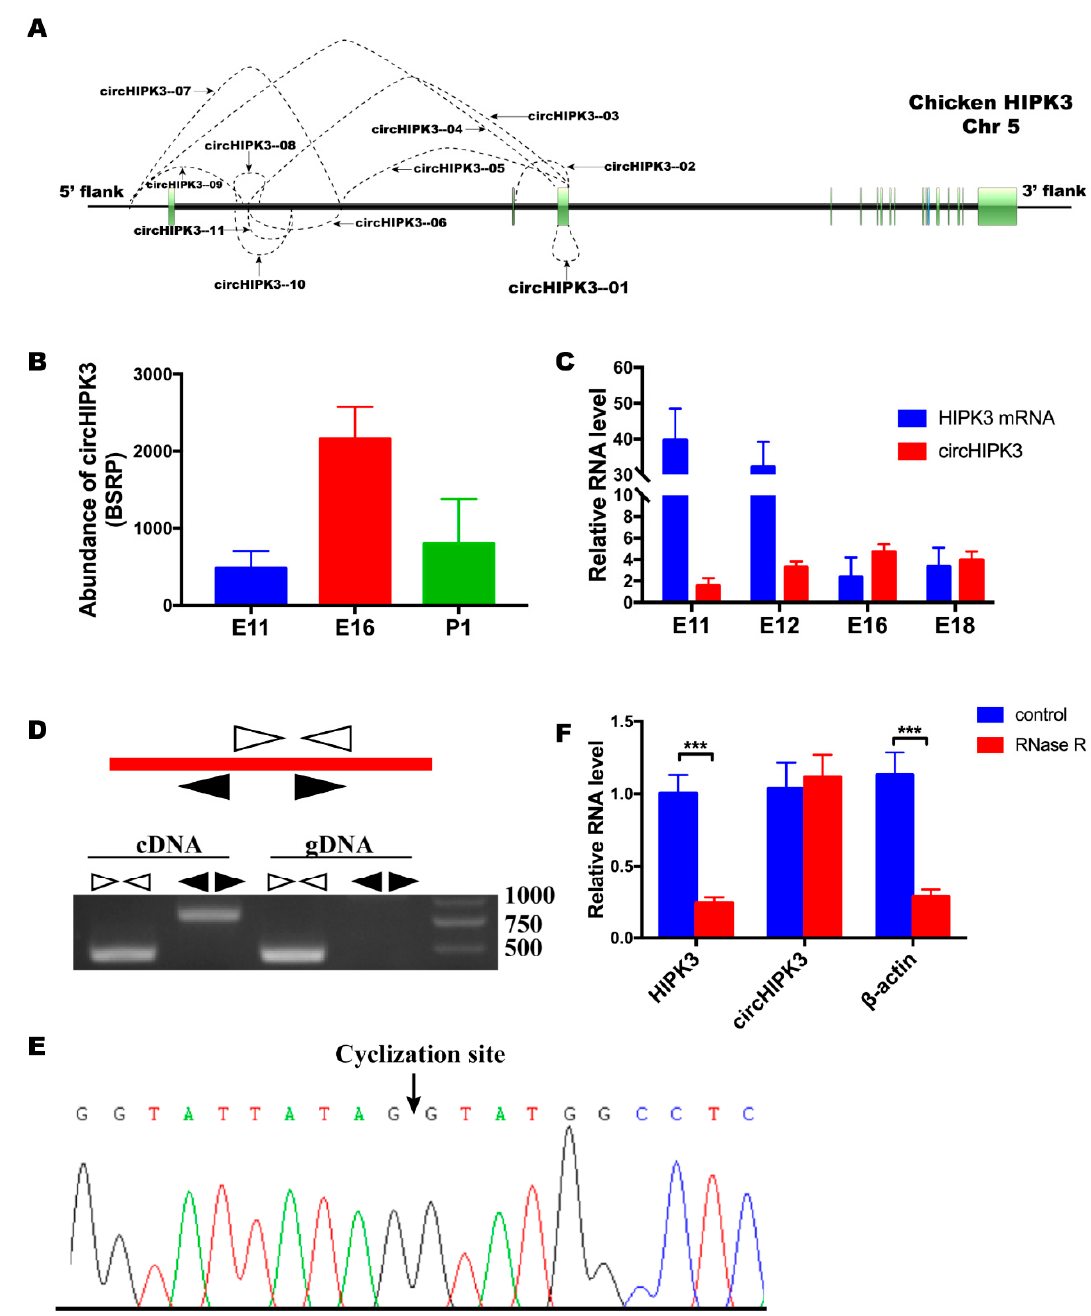
Figure 1. The differential expression and validation of circular HIPK3 (circHIPK3). ( A ) The schema of all circular RNA derived from HIPK3 . The green rectangles represent the exons of HIPK3 . ( B ) The RNA-Seq result showed that circHIPK3 was differentially expressed in E11, E16, and P1 of leg muscle. The expressed abundances were normalized as the number of back-spliced reads per million mapped reads (BSRP). ( C ) The expression profiles of circHIPK3 and HIPK3 mRNA in E11, E12, E16 and E18. ( D ) Divergent primers amplified circHIPK3 in cDNA but not genomic DNA (gDNA). White triangles represent convergent primers and black triangles represent divergent primers. ( E ) Sanger sequencing confirmed the junction sequence of circHIPK3. ( F ) Quantitative real-time PCR (qRT-PCR) showed the resistance of circHIPK3 to RNase R digestion. In all panels, values represent mean ± SEM from three independent experiments. * p < 0.05; ** p < 0.01; *** p <